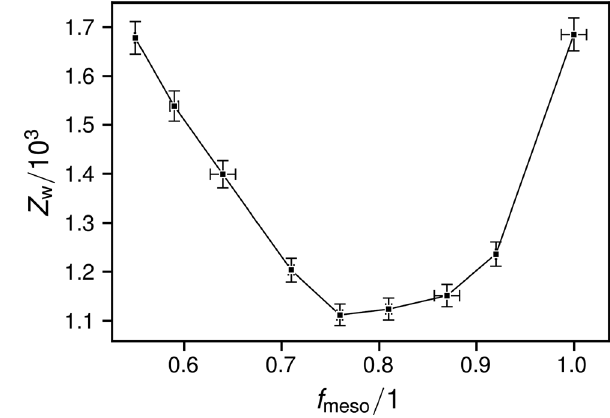
Figure 1: Weight average chain lengths of the synthesized